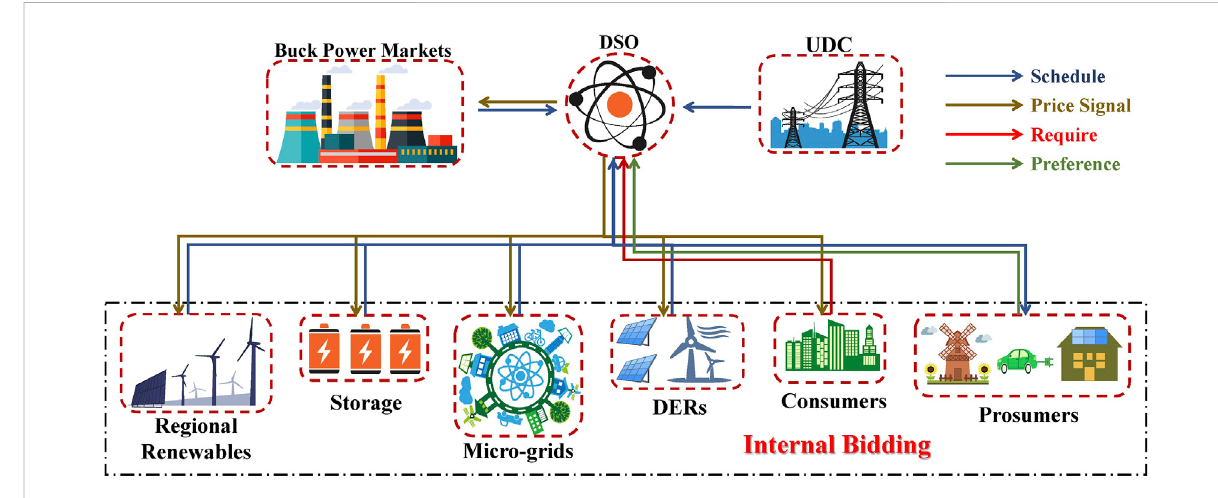
FIGURE 3 Transactive parties and their